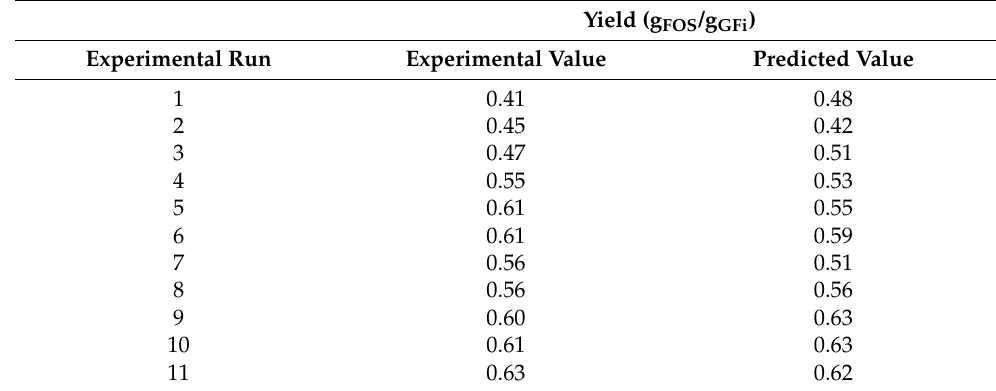
Table 3. Fructooligosaccharides production yields obtained from the experimental runs and predicted values of the central composite design.